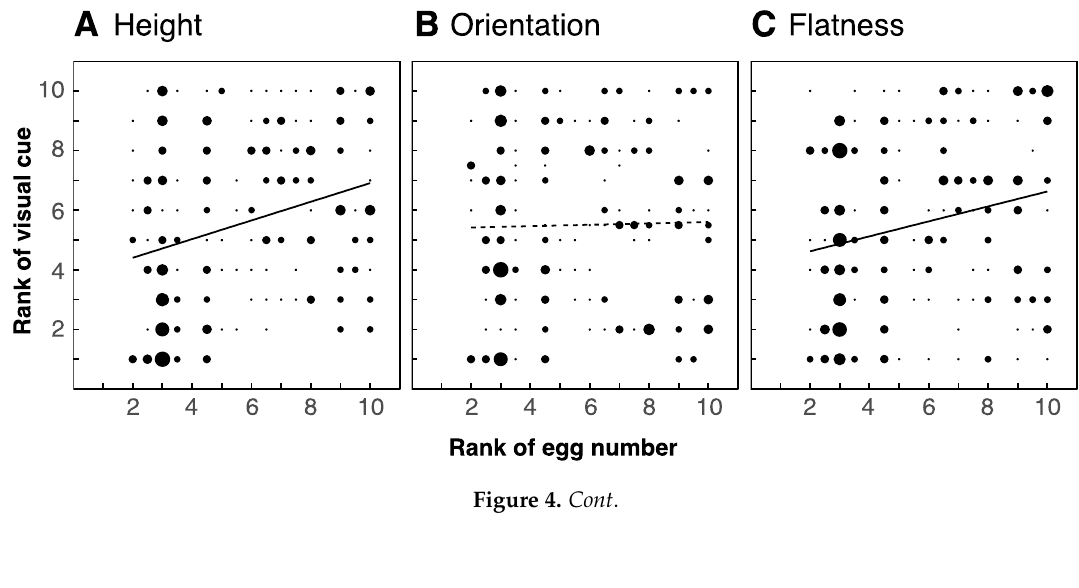
Figure 4. Correlation between morphological features of leaves and number of eggs laid. Height (( A ): r = 0.285, p= < 0 . 01), orientation (( B ): r = 0.021, p = 0.751), flatness (( C ): r = 0.229, p < 0.01), roundness (( D ): r = − 0.033, p = 0.620) and size (( E ): r = 0.998, p = 0.131). Thick regression lines denote significant correlations, dashed lines indicate non-significant correlations. Data is based on 50 leaves from five trees.